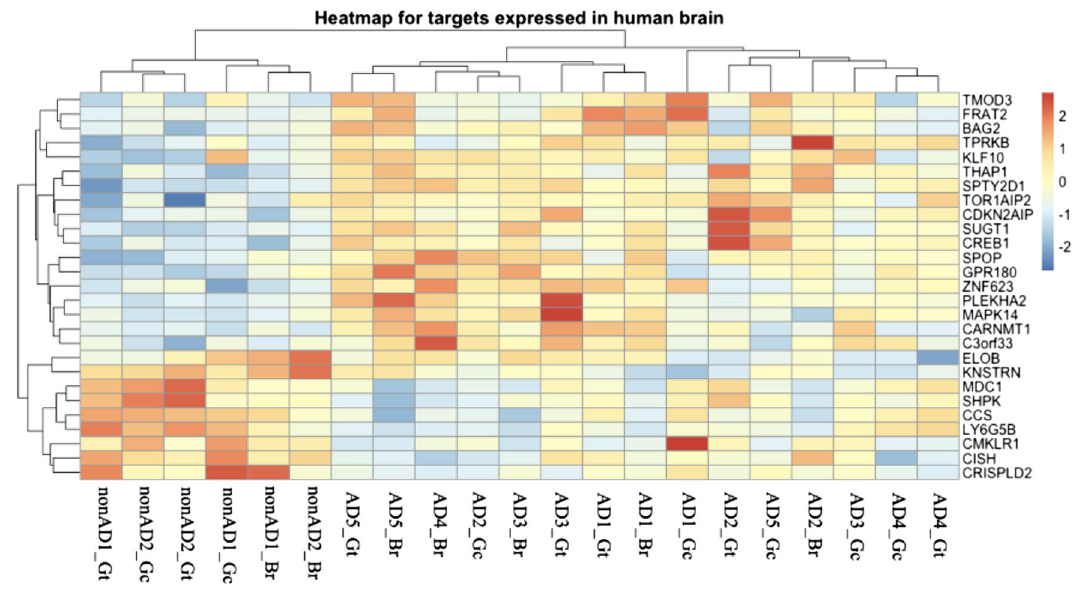
Figure 5. Heatmap of potentially AD-related gene targets ‘expression in three human brain regions from the Memories project. These 27 genes were obtained via feature selection based on gene-expression data of brain tissue. The expression of 27 genes in all three regions of human brain tissue from five AD cases and two controls were included, Gt, Gc and Br are the abbreviation of three regions that were described in “Materials and methods”, and clinical information for these cases were shown in Table